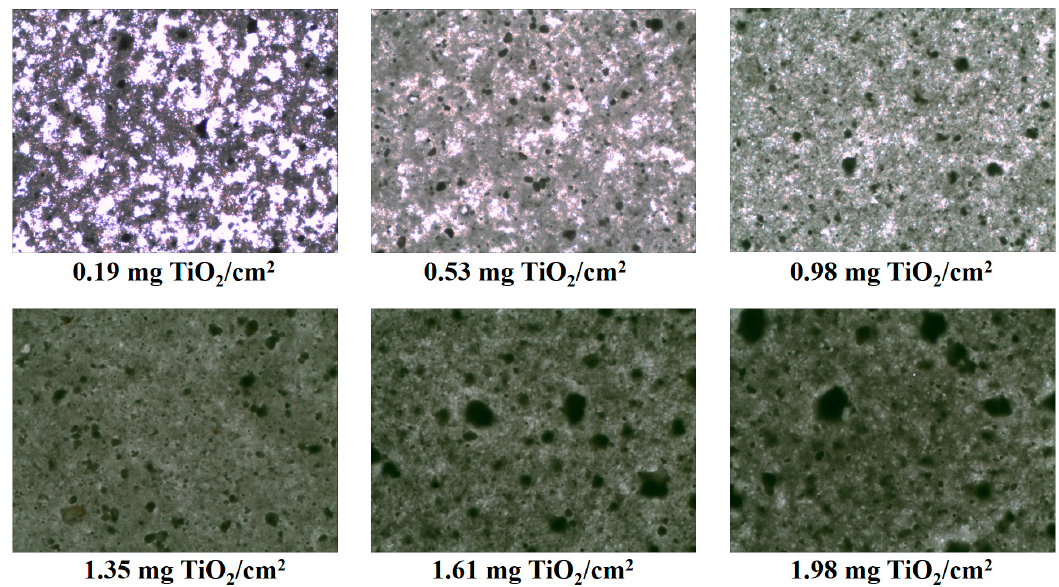
Figure 5. Microscopy images of the coated films demonstrating decreasing light transmission through increased loading/thickness of TiO 2 (×10 magnification).